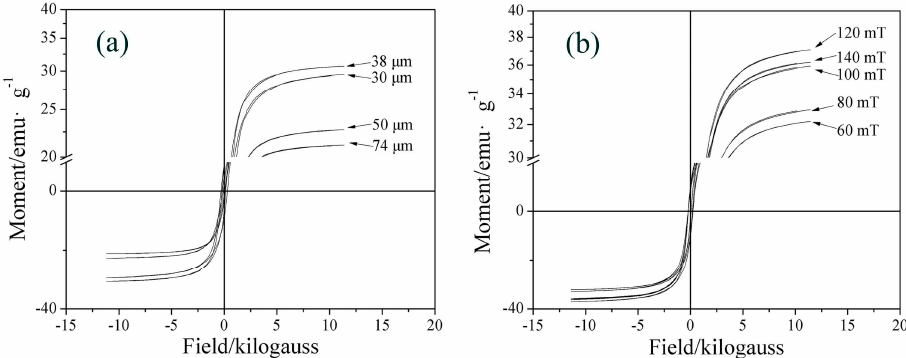
Figure 11. Effect of particle size ( a ) and magnetic flux density ( b ) on iron recovery and grade.